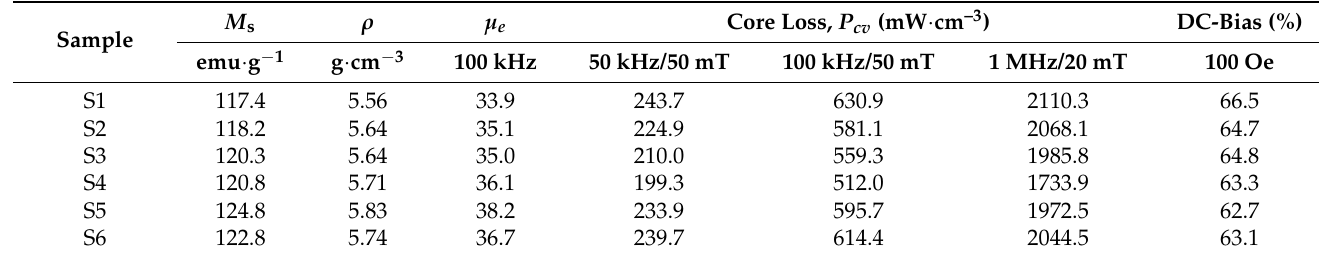
Table 1. Comparison of soft magnetic properties of SMPCs prepared in this work.